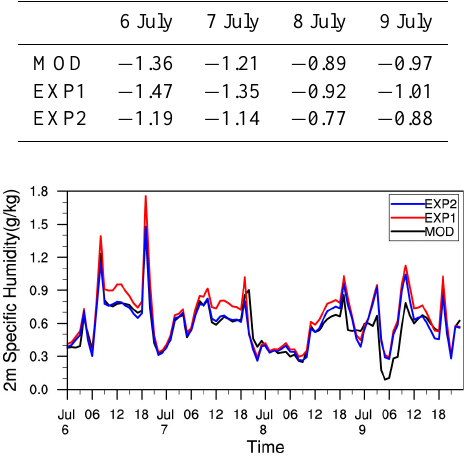
Fig. 7. The differences of specific humidity at 2m above ground be- tween the oasis and the desert in a time series from the MOD, EXP1 and EXP2 simulations (the difference was calculated by subtracting the average specific humidity over the desert from the average spe- cific humidity over the